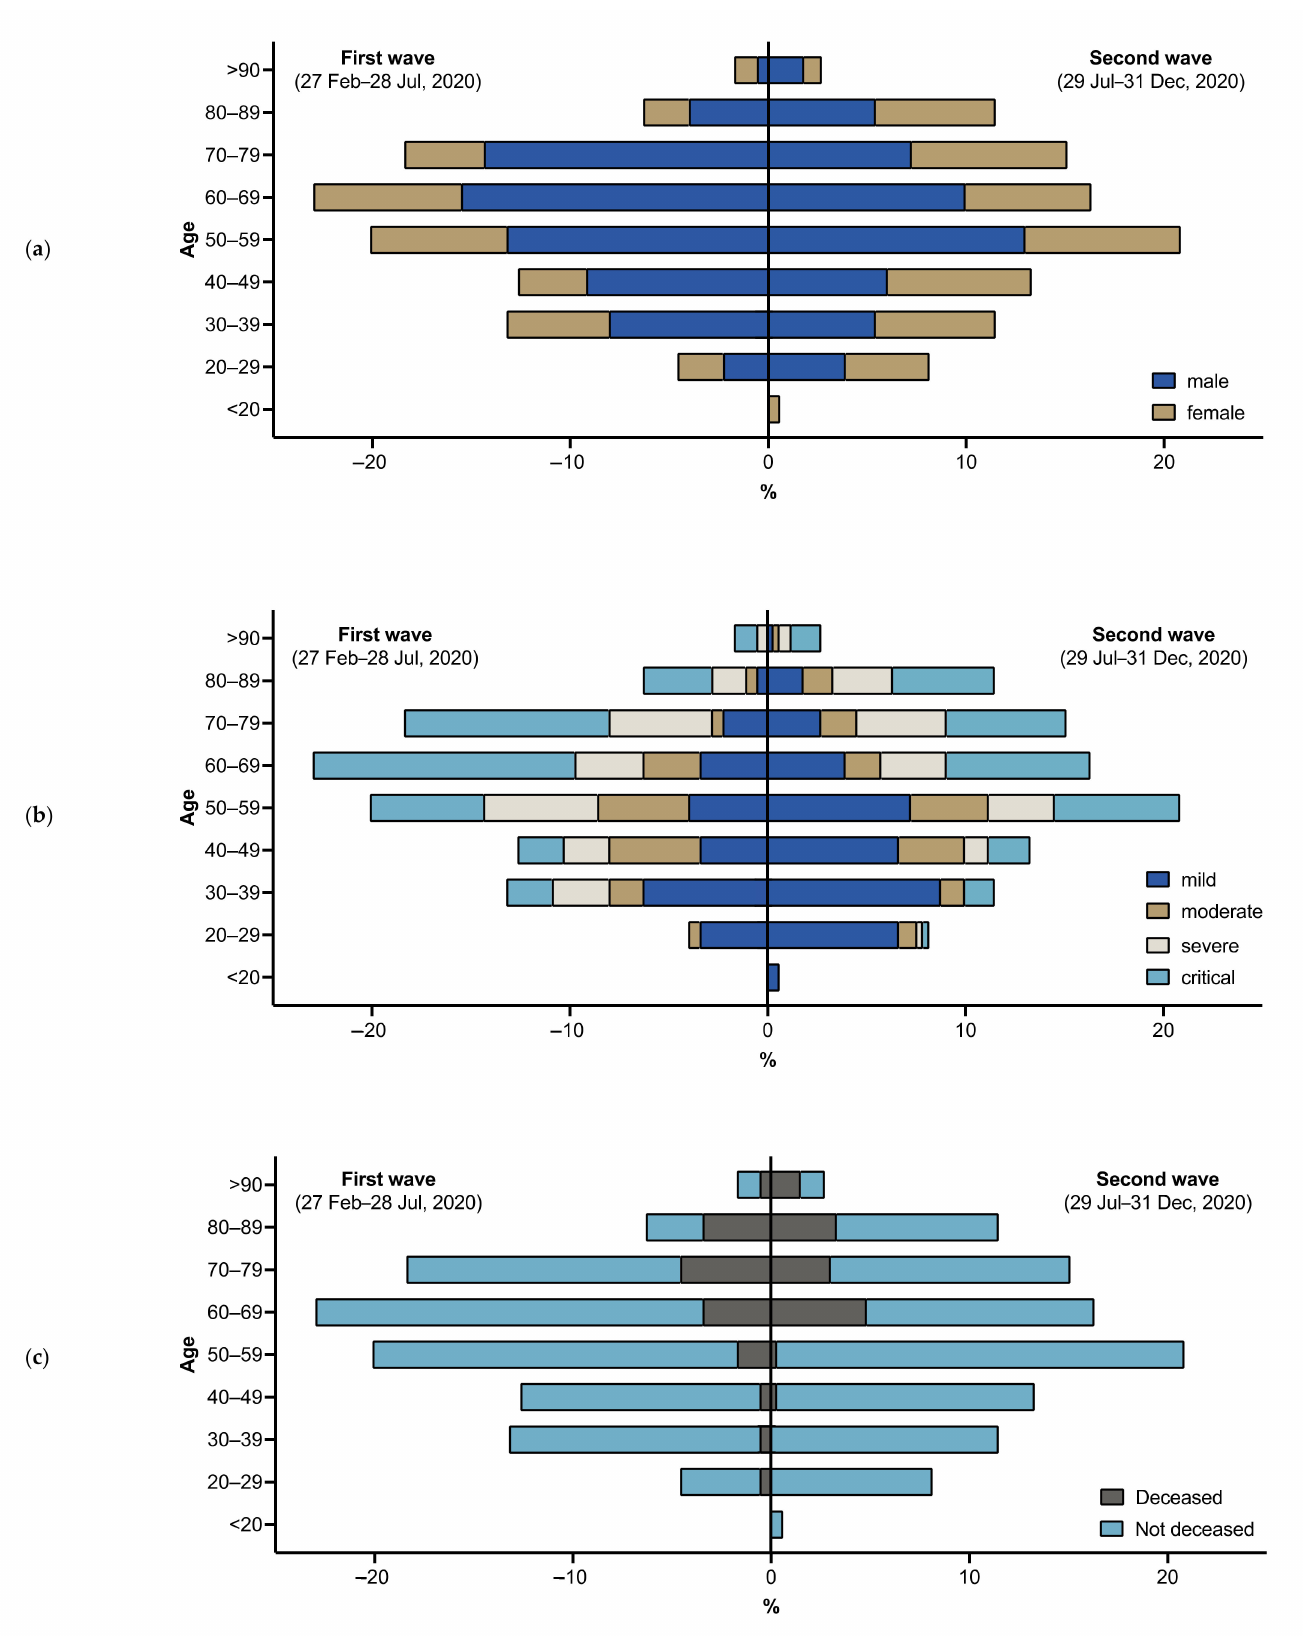
Figure 2. ( a ) Sex distribution, ( b ) disease severity, and ( c ) and in-hospital mortality of COVID-19 patients at our center during the first wave (left) and second wave (right) of the pandemic stratified by age